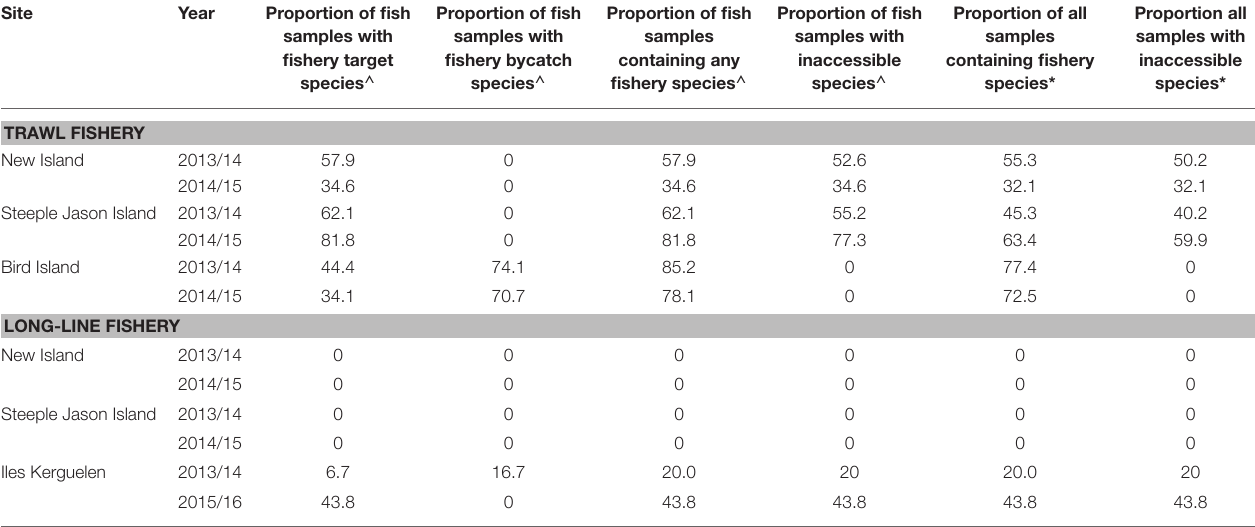
TABLE 7 | The proportion of scat samples that contained DNA from target and bycaught species in commercial fisheries operating in adjacent waters during the study. Site Year Proportion of fish